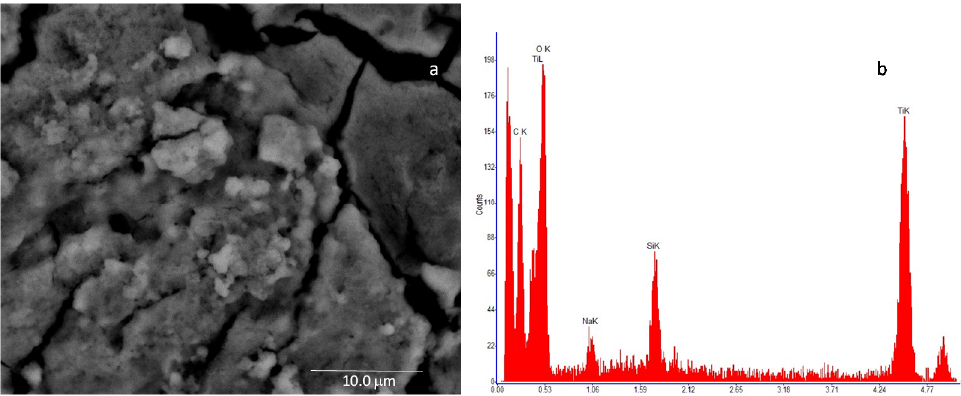
Figure 6. High-resolution field emission scanning electron microscopy (SEM) image of the TiO 2 sample. The microscopic investigation is performed with a Quanta 400 (FEI) emission scanning electron microscope, operated at 20.0 kV: ( a )—deposited film (scale bar = 10 mm) and ( b )—result of the Energy Dispersive Spectroscopy (EDS) of the analyzed sample.